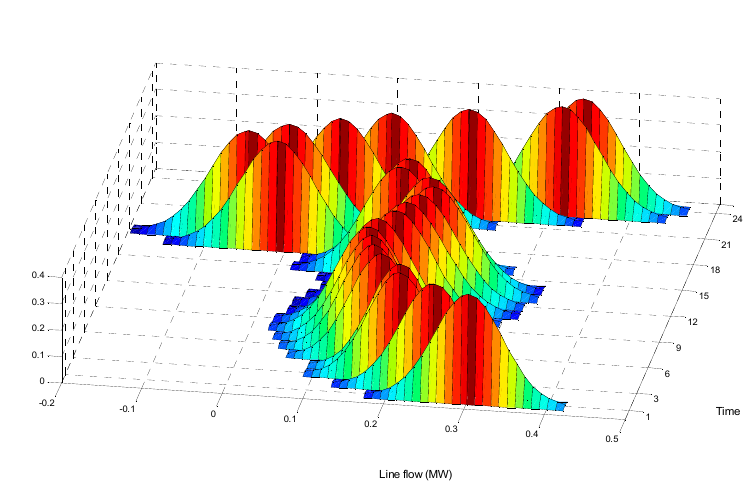
Figure 11. Line flow probabilistic distribution of branch 31–32 in Case 4.